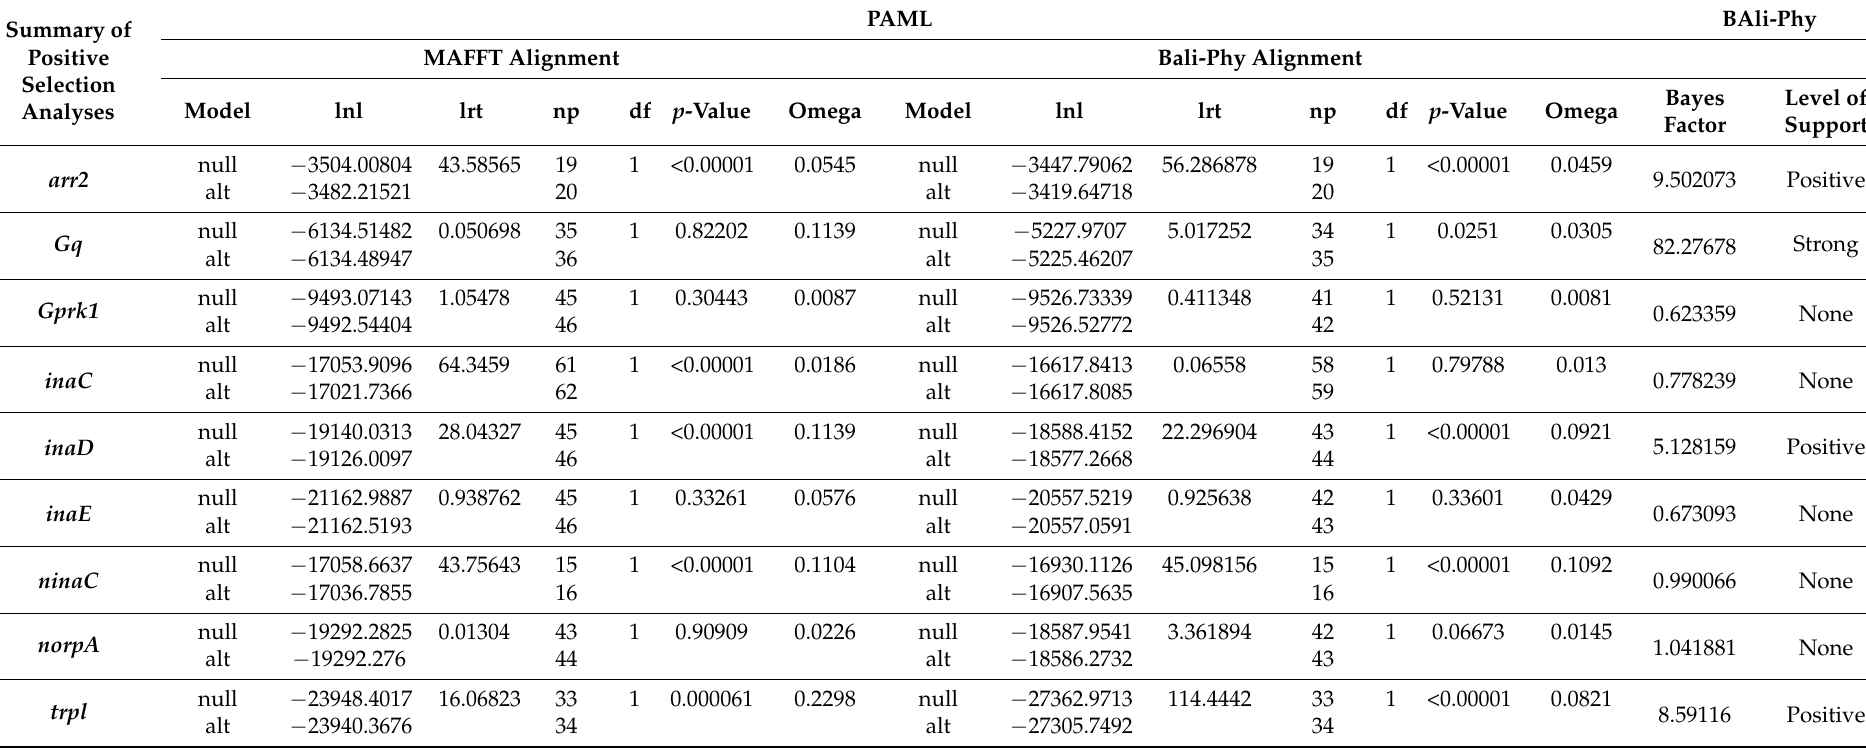
Table 2. Summary of positive selection analyses carried out in PAML and BAli-Phy. P value for lrt significance is 0.05. Level of support for Bayes Factor is after